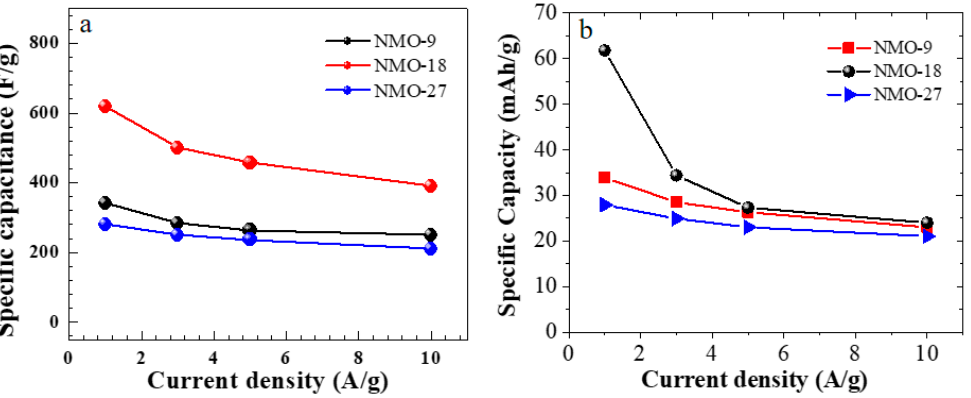
Figure 6. ( a ) Specific capacitance as a function of current density for all the samples of NMO-9, NMO-18, and NMO-27; ( b ) The response of specific capacity to current density for NMO-9, NMO-18, and NMO-27.